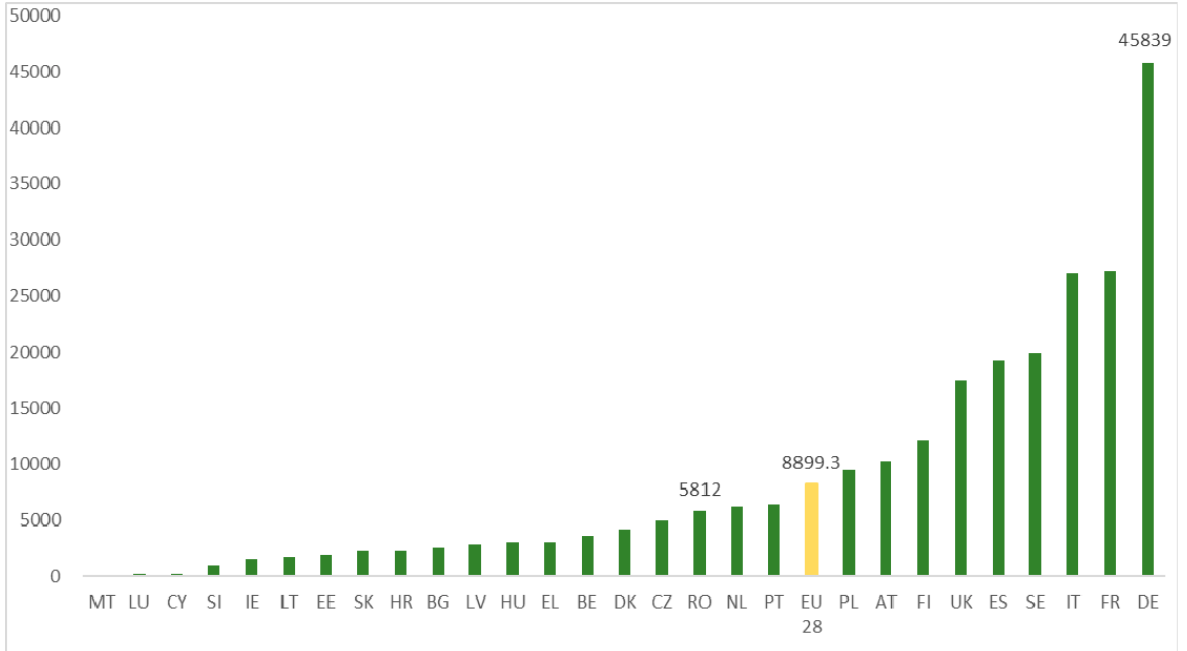
Figure 1. Production of renewable energy in EU-28 in 2019 (toe)